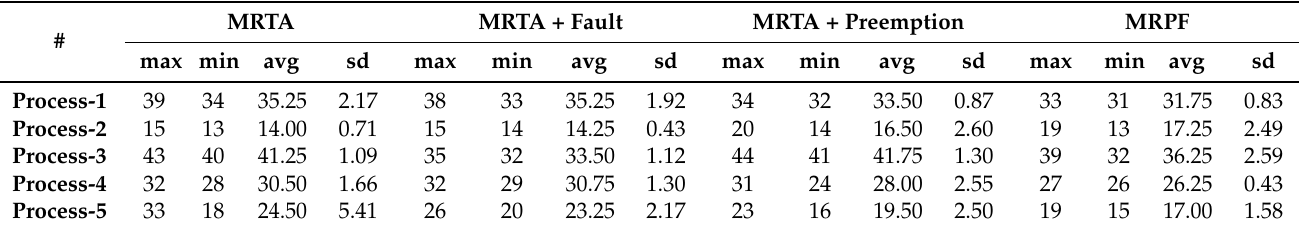
Table 8. Running ticks